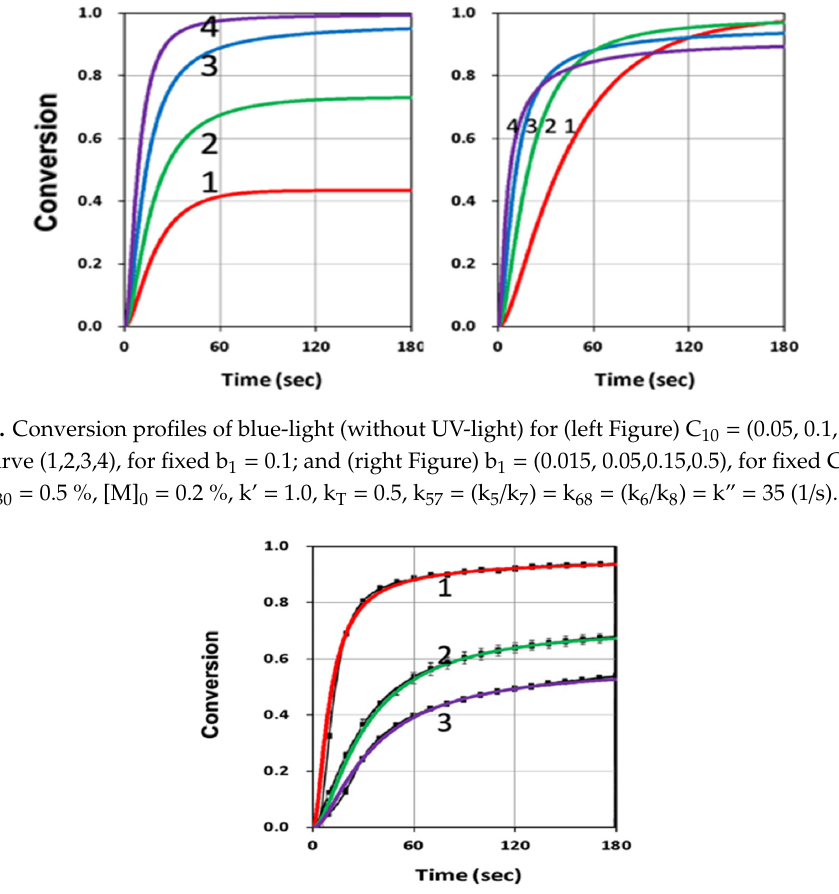
Figure 3. The same as Figure 2 but for various k’ = (1.0, 0.3, 0.19), for curves (1,2,3), for fixed C 10 = 0.2%, and adjusted b 1 = (0.15, 0.05, 0.05) to fit the measured data of de Beer et al. [10].